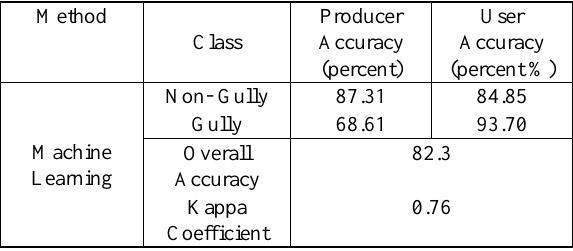
Table 4. The results of accuracy assessment of image classification